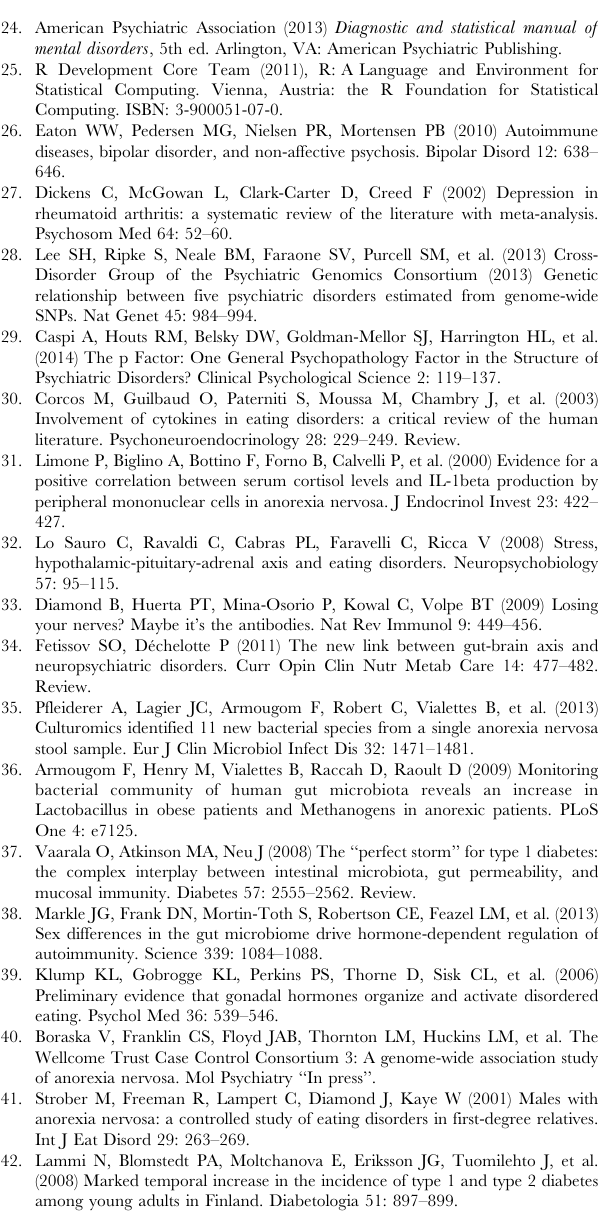
Figure S1 Incidence rates (1/1000) as a function of follow-up time with 95% confidence intervals for a composite of all autoimmune diseases. Top: the whole study population; bottom, left: all patients with eating disorders; bottom, right: all control individuals. Table S1 Categorization of autoimmune diseases and diagnostic codes for each revision (8, 9, 10) of Interna- tional Classification of Diseases (ICD) as applied in the study. Table S2 Autoimmune disease status per each autoim- mune disease at the end of the study period covering the